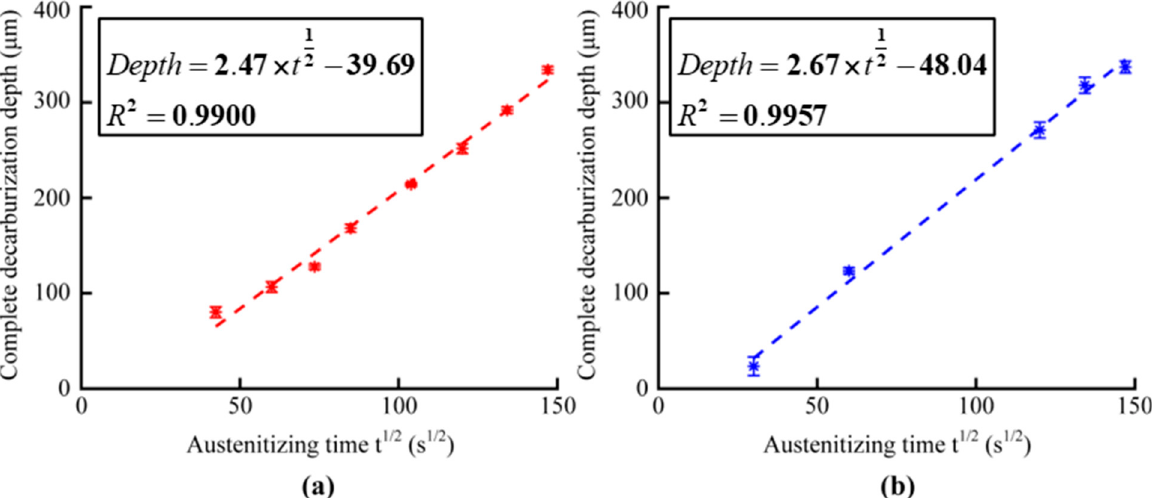
Figure 6. Complete decarburization depth of samples with an ( a ) martensitic core and ( b ) pearlitic core, depending on austenitizing treatment time. Four positions of each sample were measured.